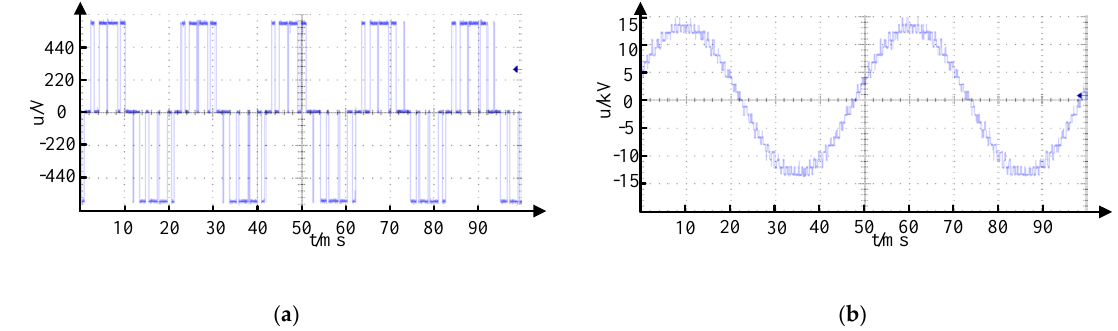
Figure 16. The output voltage waveform: ( a ) Single power module; ( b ) one-phase.